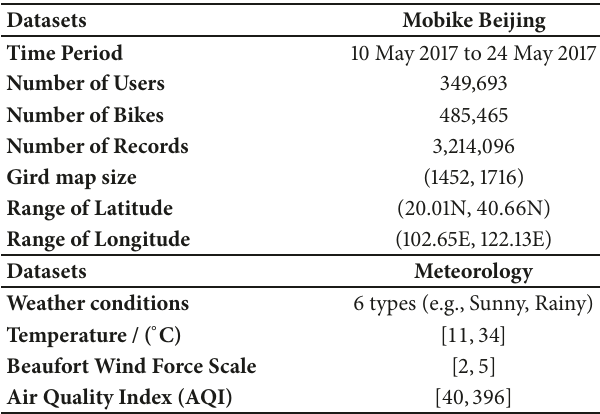
Table 5: The details of Mobike